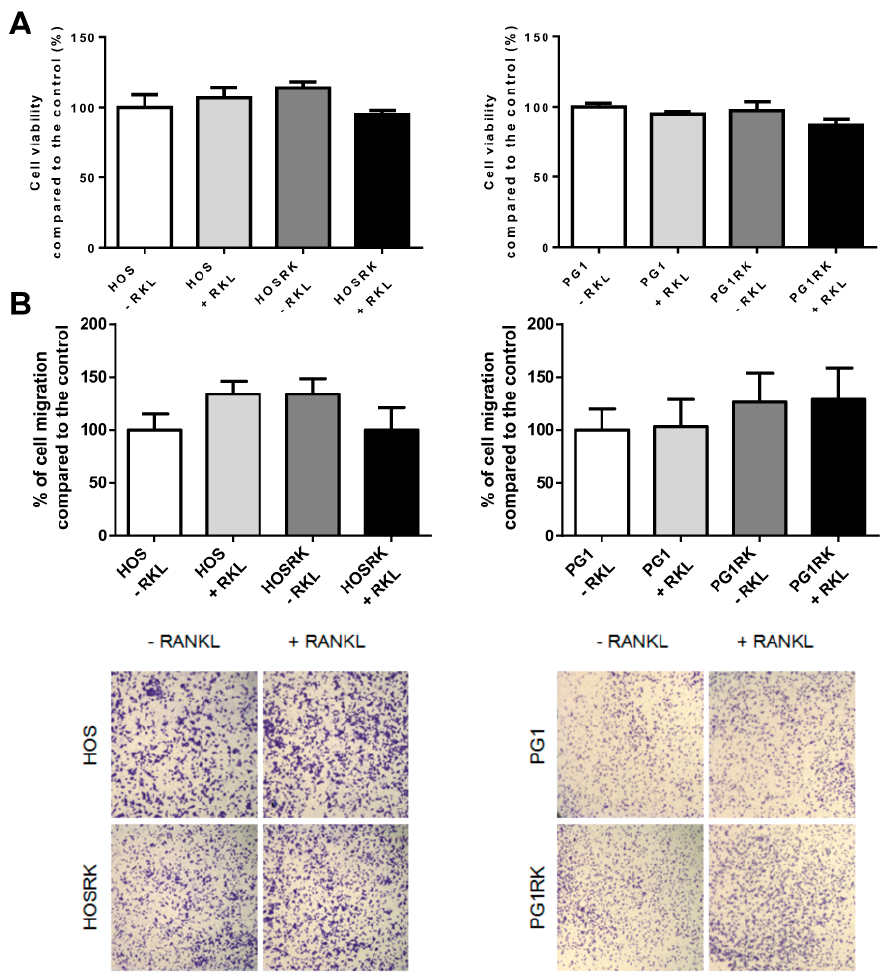
Figure 2. Consequences of RANK over-expression in osteosarcoma cells on cell viability ( A ) and migration ( B ). A moderate decrease (tendency) in the cell viability in response to the addition of RANKL to the culture medium was observed for both RANK over-expressing HOS cells and PG1 cells ( A ). For cell migration, which was evaluated with Boyden chambers, no significant impact of RANK over-expression and RANKL stimulation was observed, regardless of the cell-line considered ( B ).